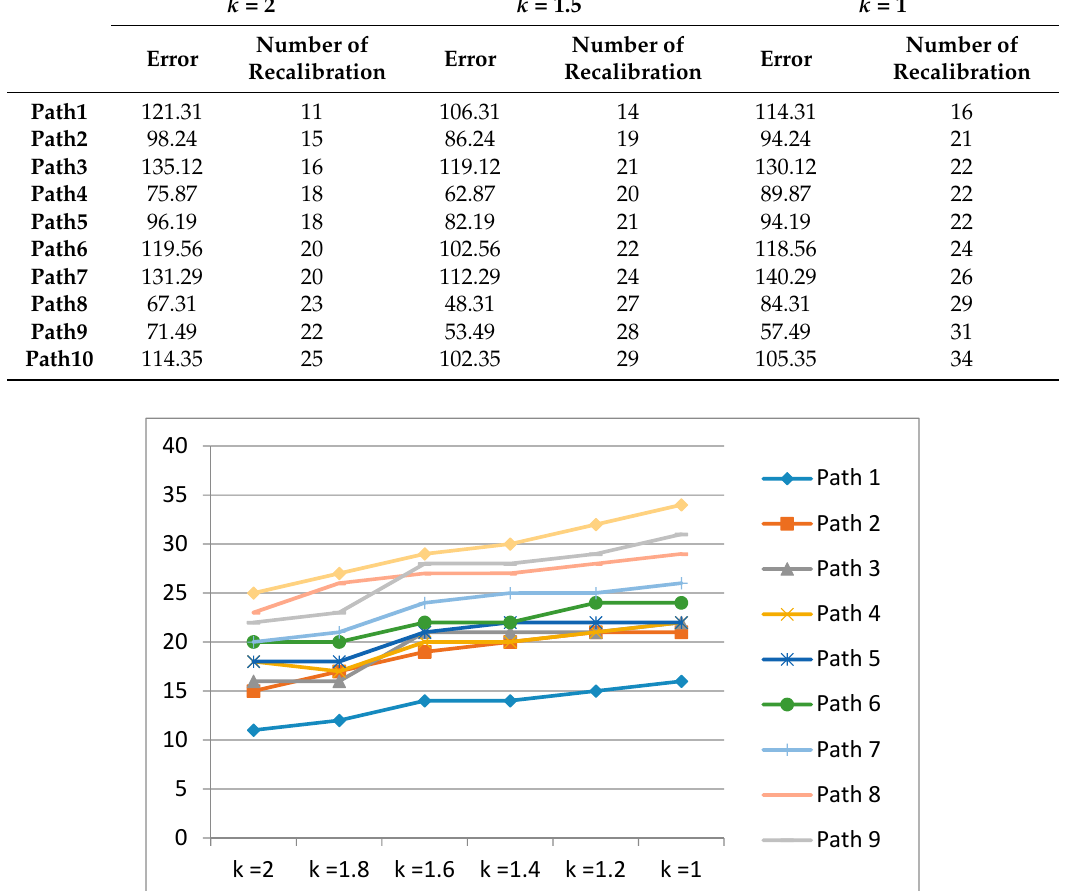
Figure 10. Number of recalibrations for k values in large test area (unit of y-axis: recalibration frequency).